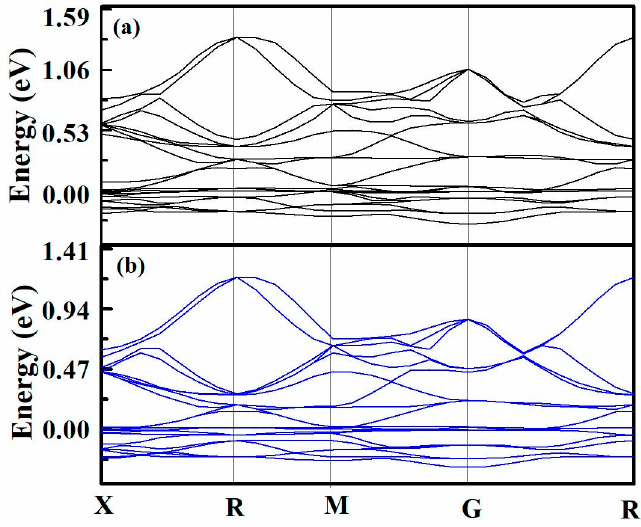
Figure 12. Electronic band structures of ( a ) graphene-Ni and ( b ) graphene-Cu composite systems.